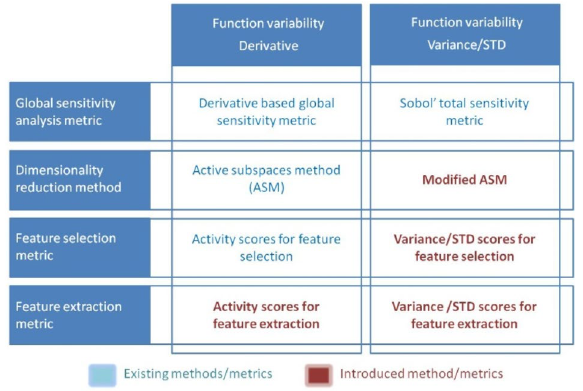
Figure 1. Overview of derivative and variance/STD based methods and